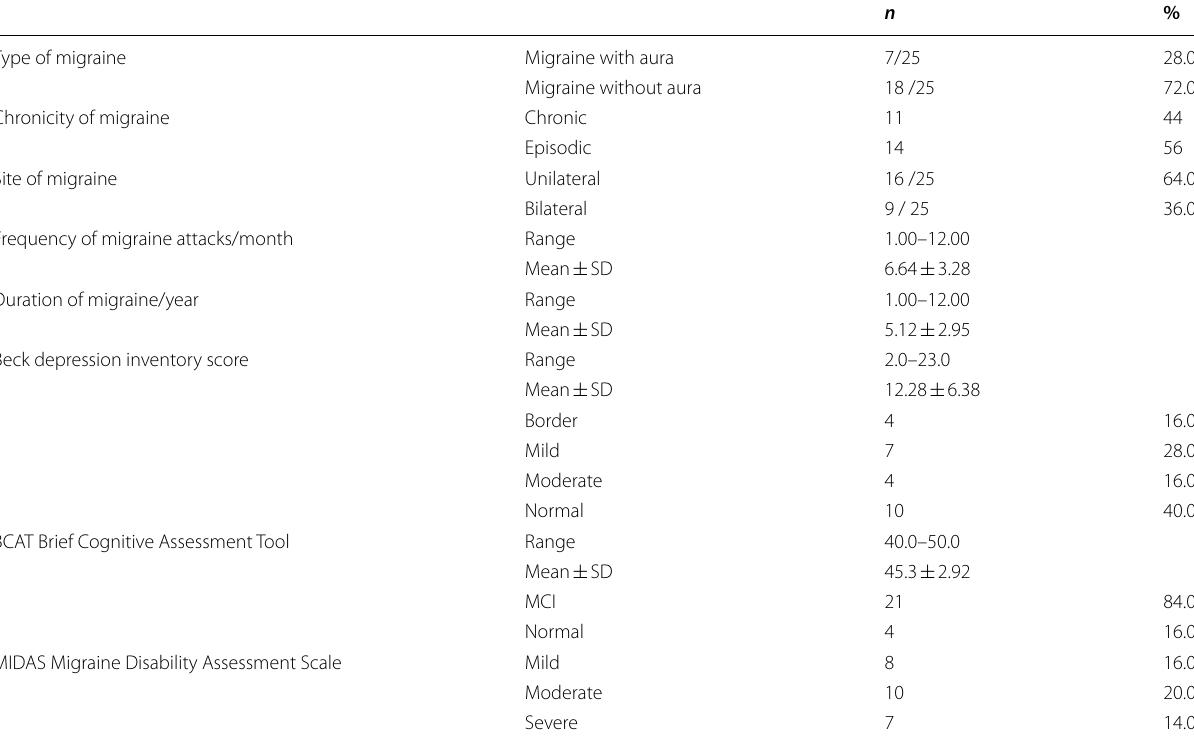
Table 1 Clinical data of patients